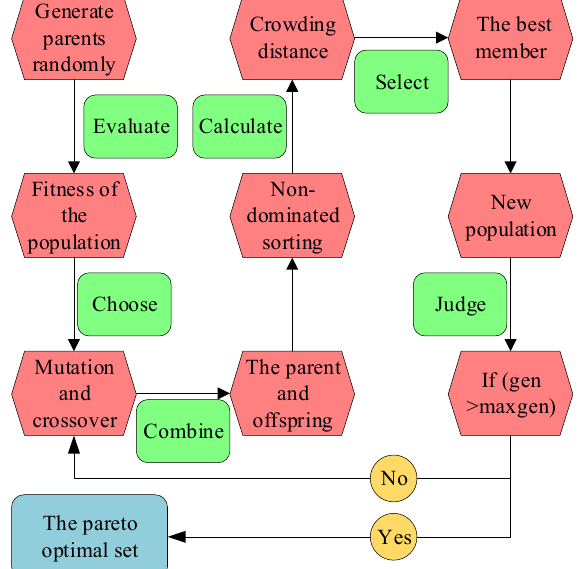
Figure 3. Multi-objective genetic algorithm diagram (non-dominated sorting genetic algorithm II, NSGA-II).